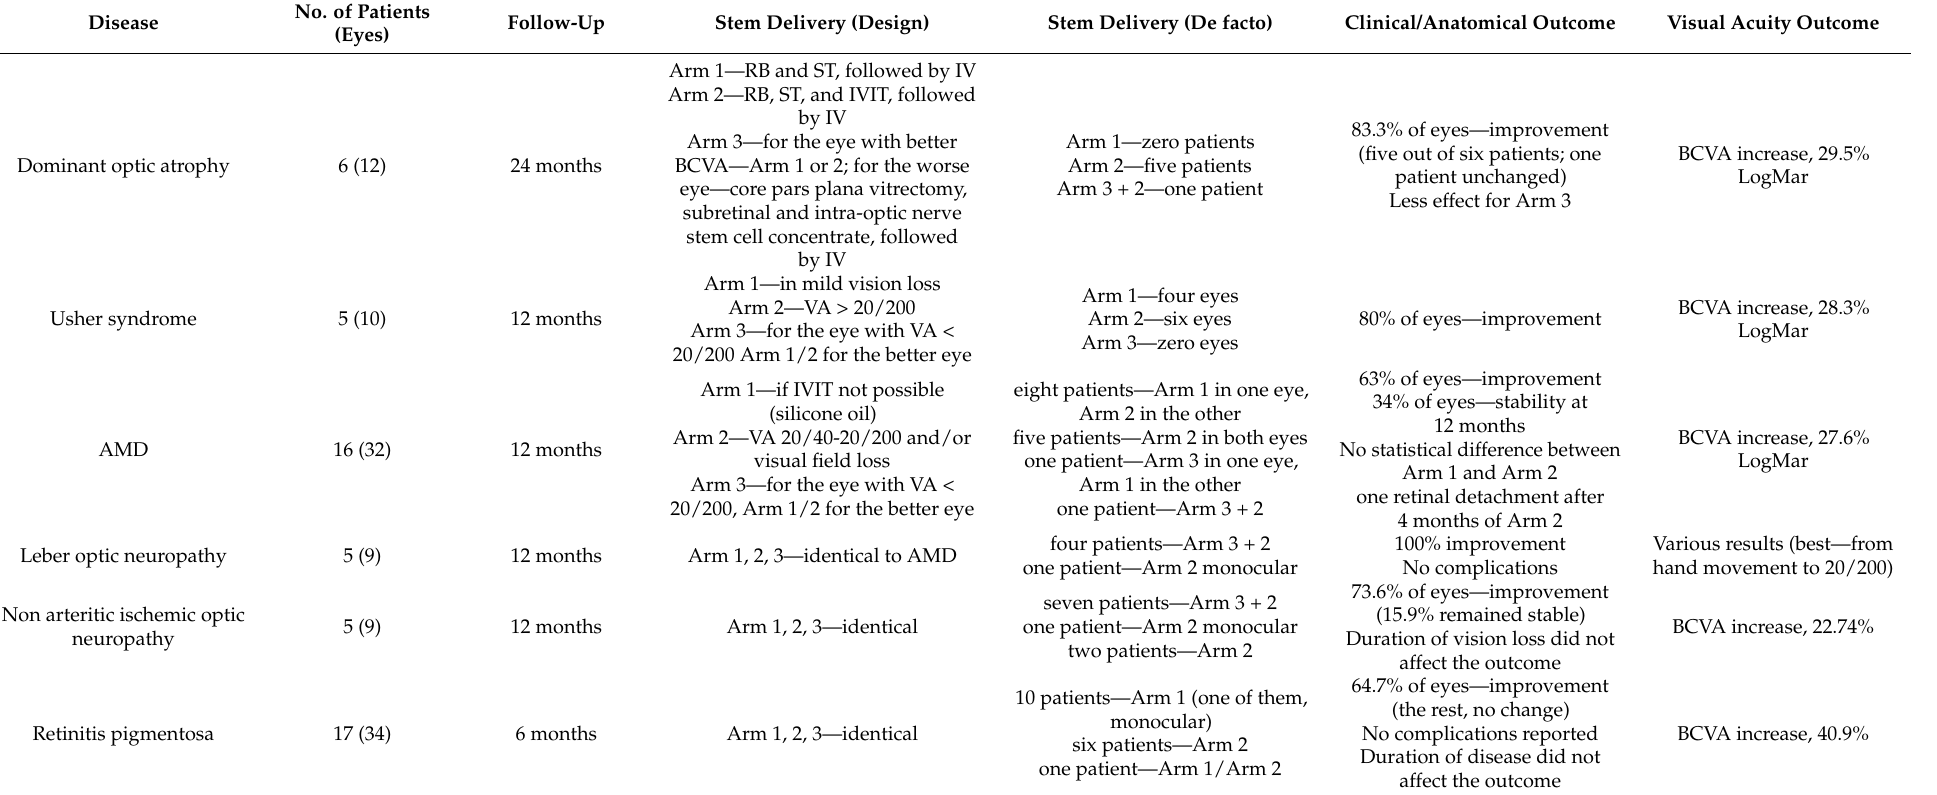
Table 3. Stem cell ophthalmology treatment study (SCOTS). Design and outcome (Weiss et